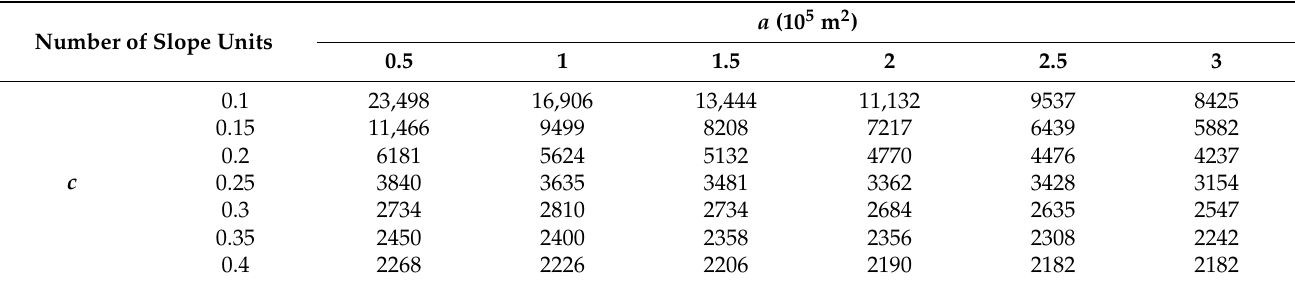
Table 2. The number of Slope Units at Different